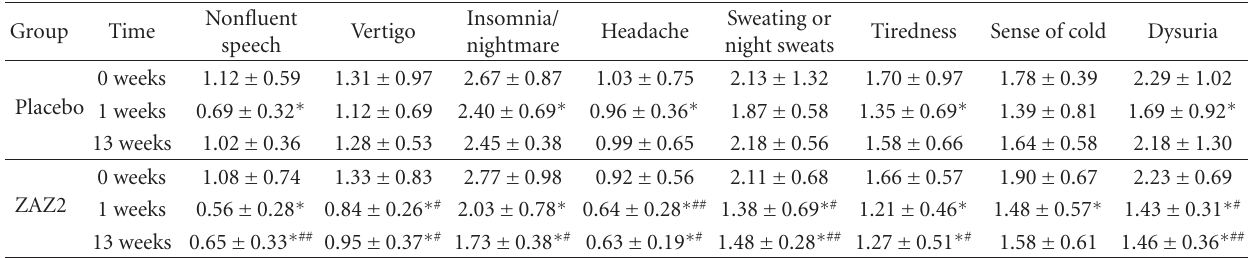
Table 3: E ff ects on secondary symptoms of PD.